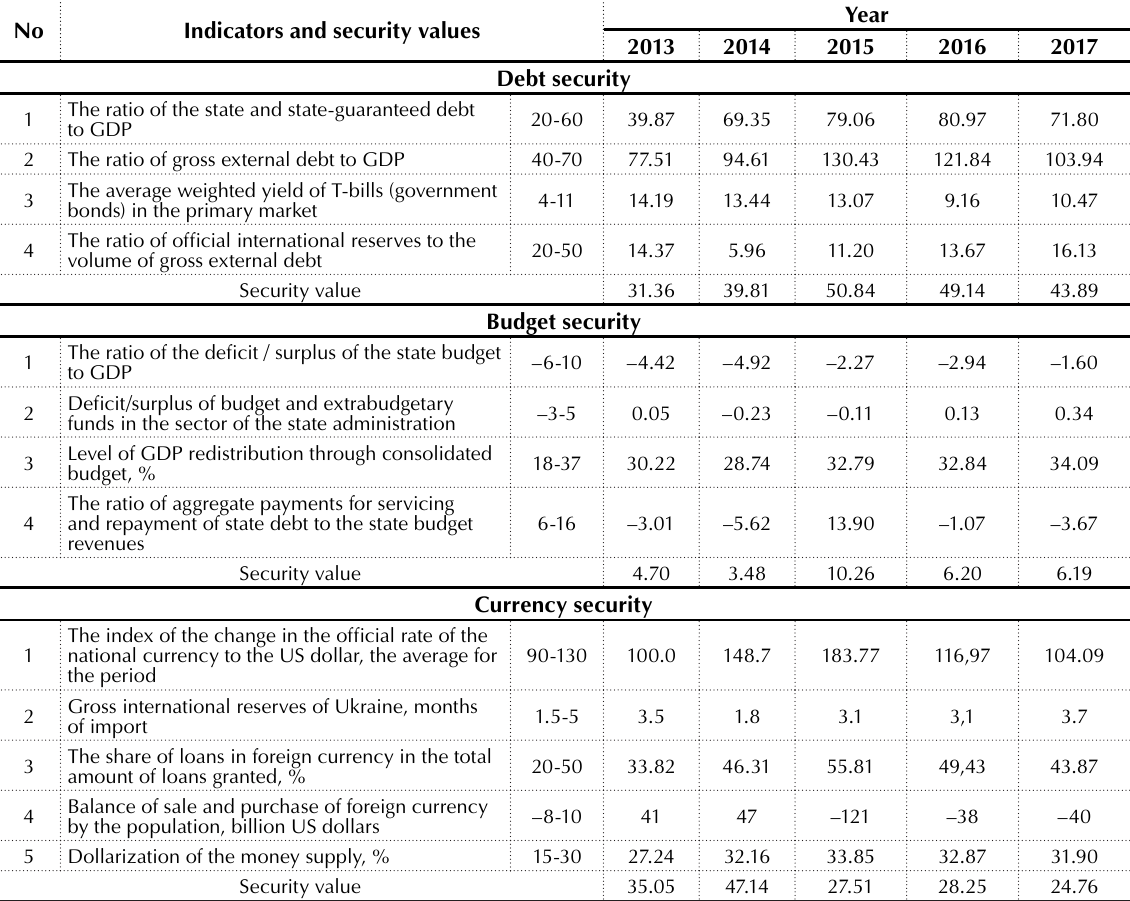
Table 2. Indicators of debt, budget and currency security of Ukraine in the period 2013–2017